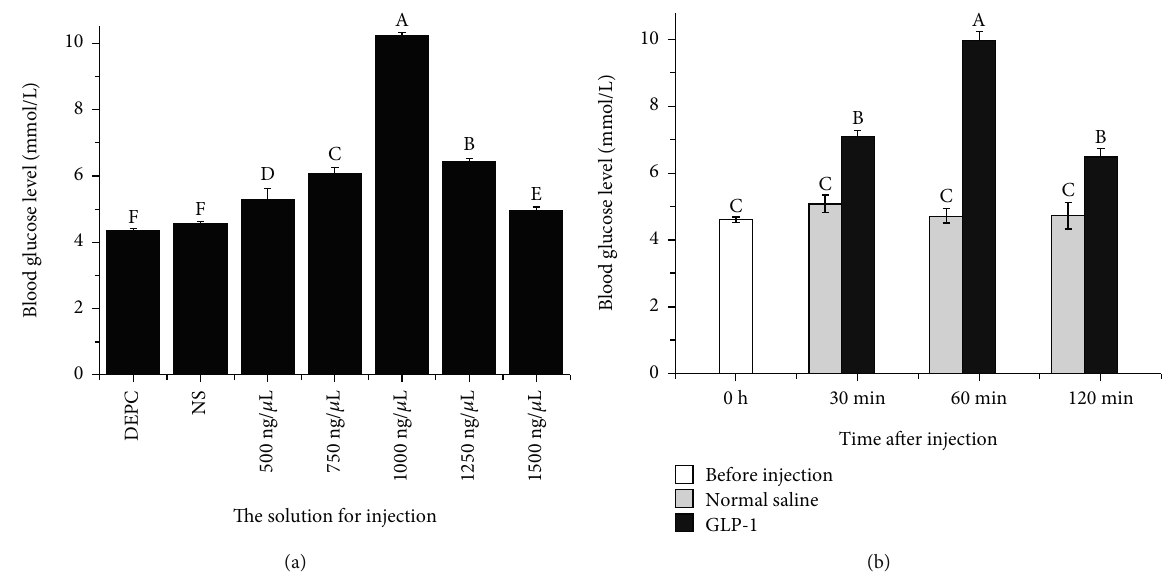
Figure 5: E ff ects of intraperitoneal injection of GLP-1 on blood glucose levels of S. denticulatus . (a) The e ff ects of di ff erent concentrations of DEPC water, normal saline (NS), and GLP-1 injection on blood glucose. (b) The e ff ects of GLP-1 injection on blood glucose levels at di ff erent time points. Di ff erent uppercase letters indicate the values with signi fi cant di ff erences ( P < 0 : 05